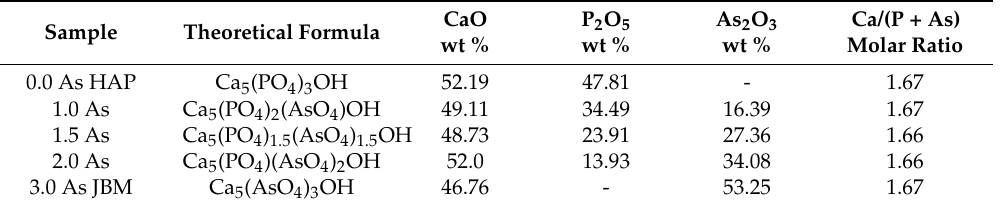
Table 2. Elemental composition of the synthesized